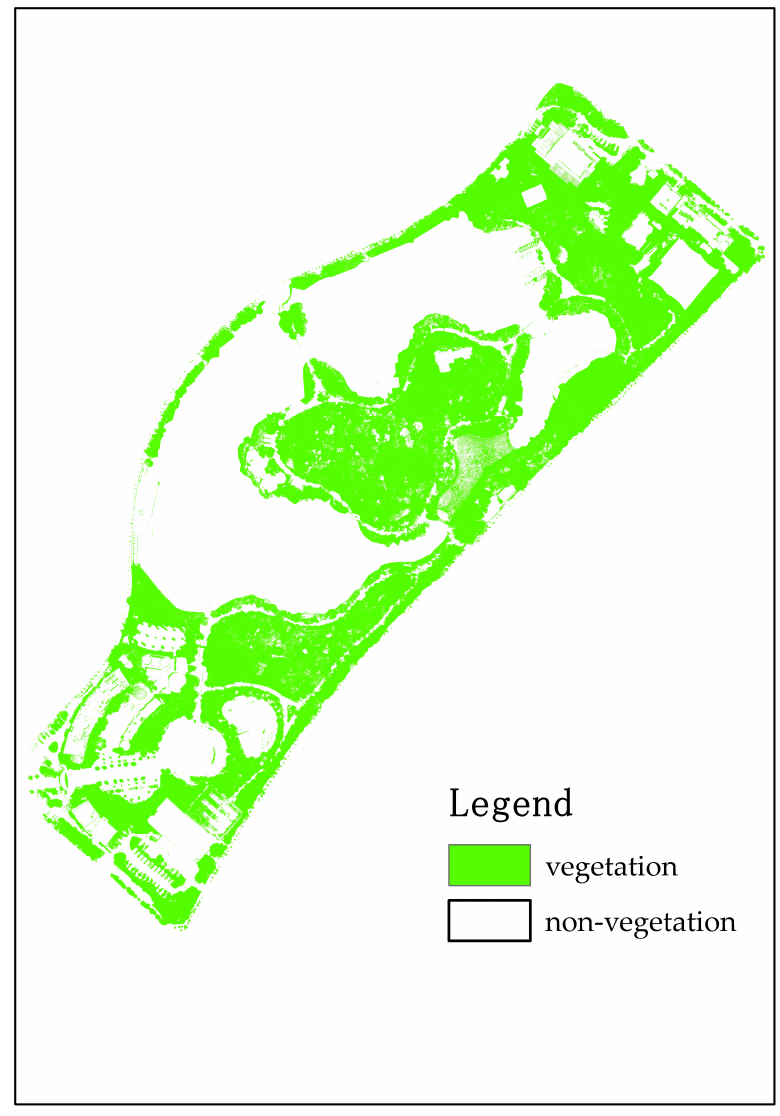
Figure 4. Vegetation distribution in YueYaTan Park.